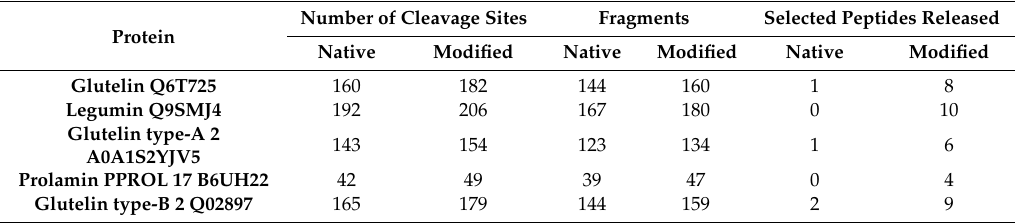
Figure 1. Sequences of ( A ) rice glutelin Q6T725, ( B ) chickpea legumin Q9SMJ4, ( C ) chickpea glutelin type B-2 Q02897, ( D ) chickpea gutelin type A-2 A0A1S2YJV5, and ( E ) maize prolamin PPROL 17 B6UH22 and their modifications. The gray squares indicate selected bioactive peptides, and the arrows indicate modifications in the amino acid sequences. Table 3. Number of peptides released after modifications.